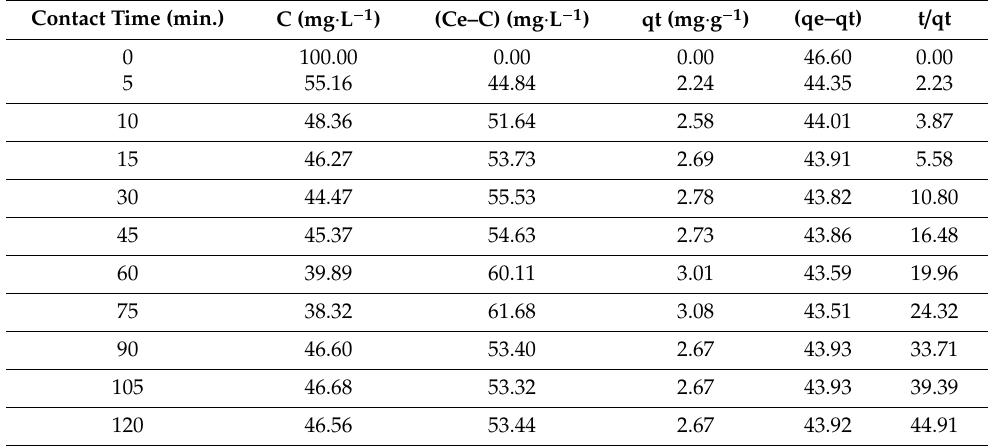
Table 3. Experimental results in the determination of the kinetic model with different contact times of the Mn (II) removal process with CP. Contact Time (min.)